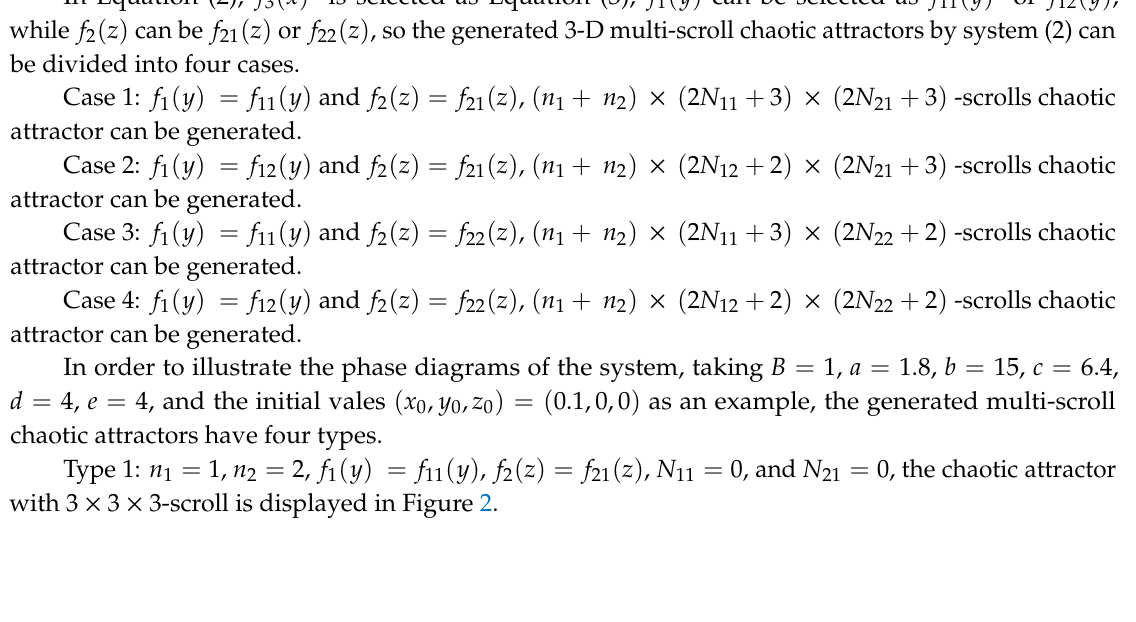
× + -scrolls chaotic